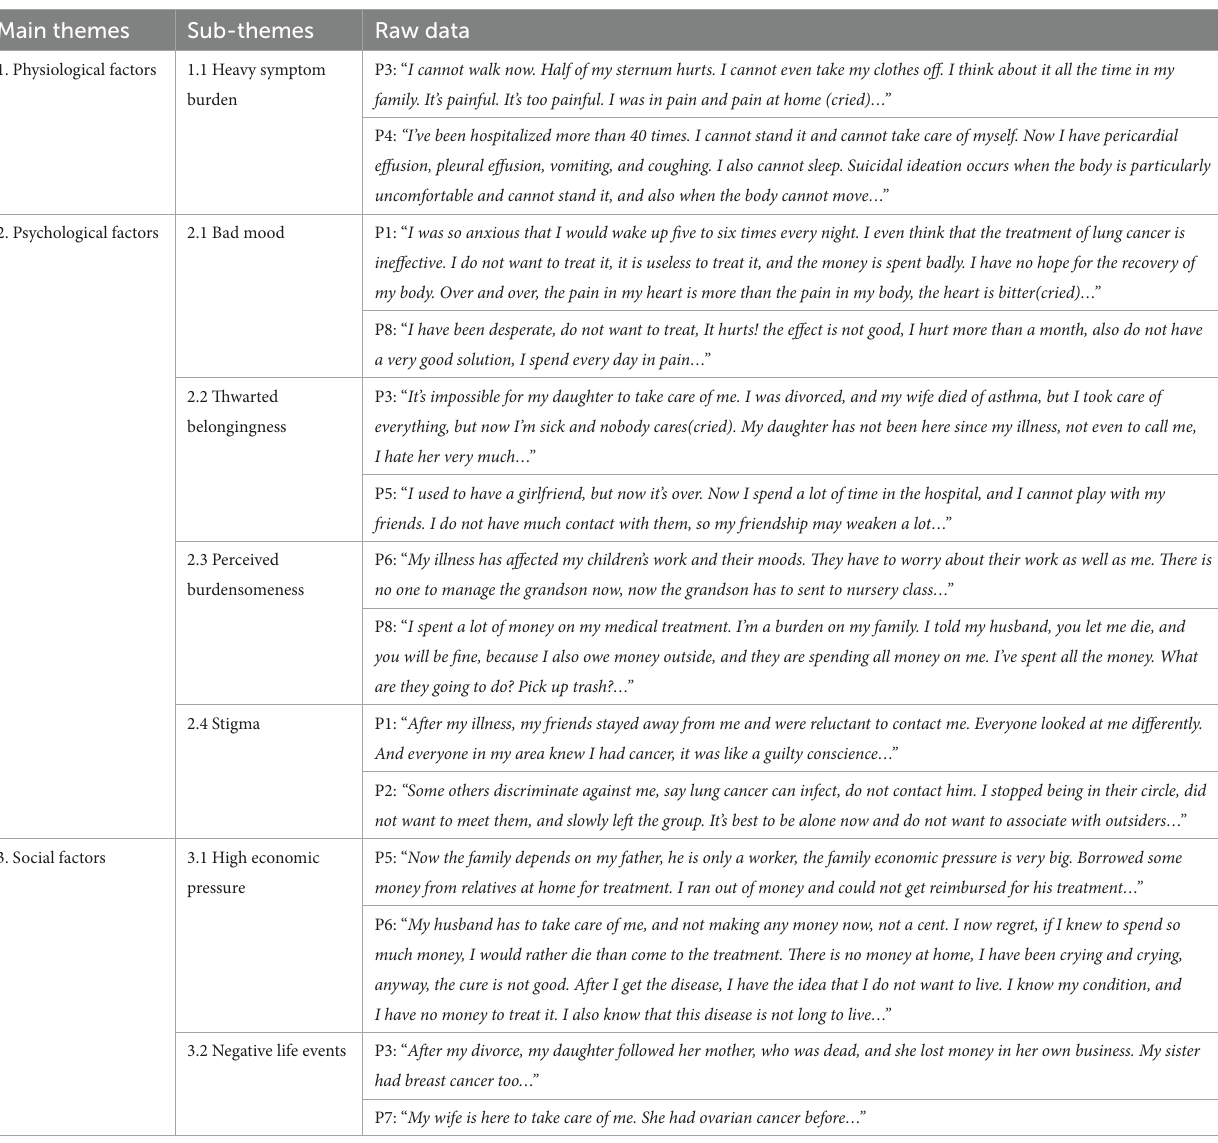
TABLE 5 Themes extraction of interview data from hospitalized lung cancer patients with suicidal ideation. Main